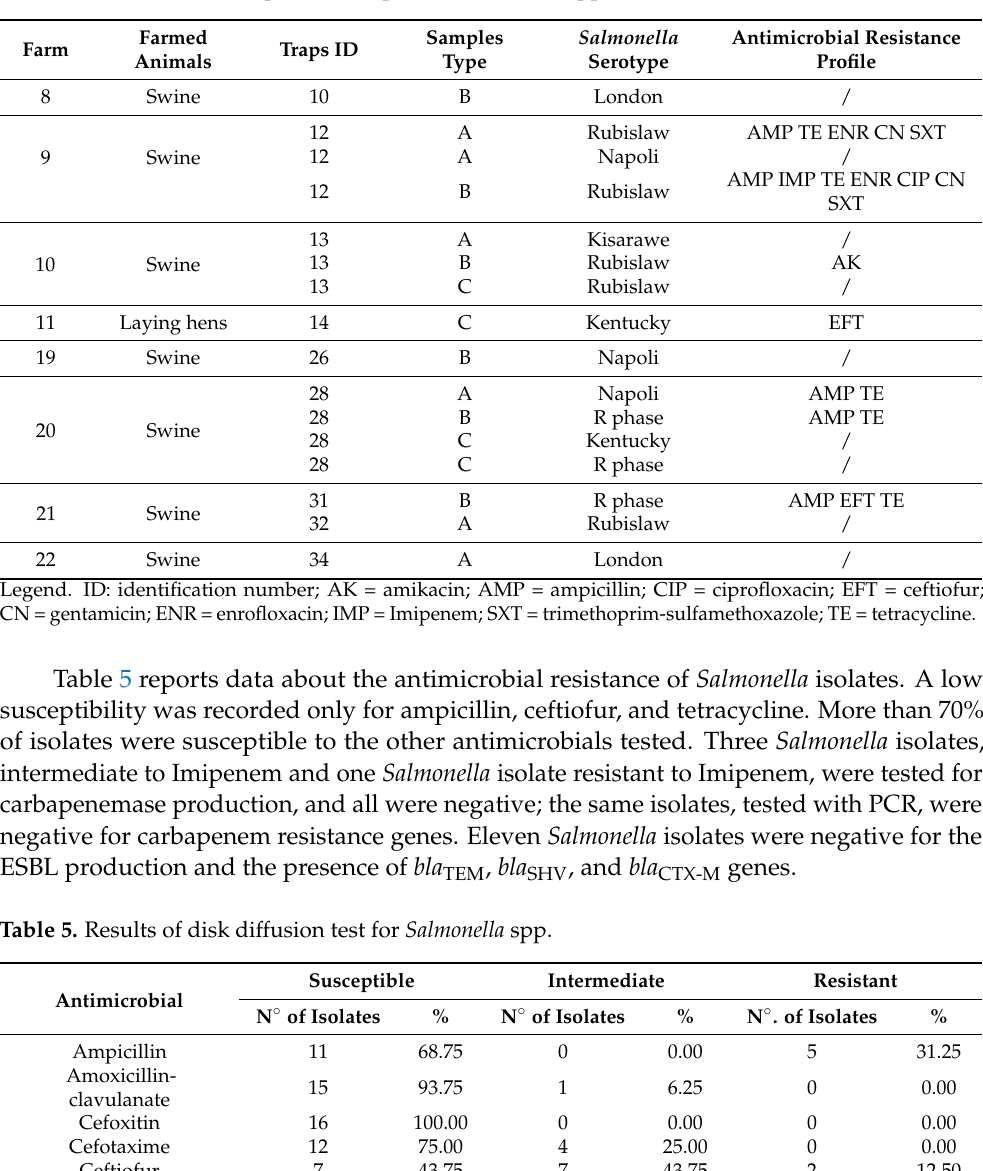
Table 4. Positive farms, traps, and samples for Salmonella spp. and detected serovars.